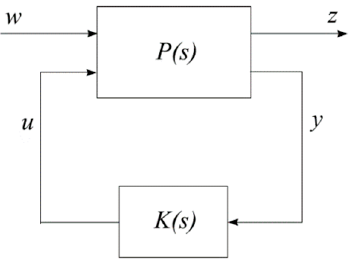
Figure 13. Standard H ∞ configuration [73].